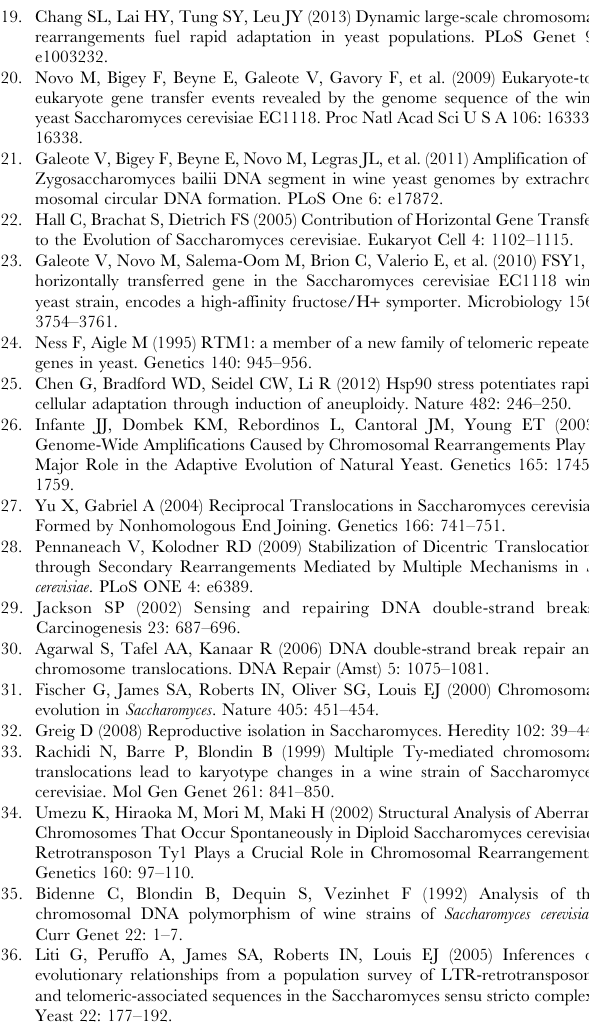
Table S4 Reads were done in pairs. See Materials and Methods for description of the assembly process. Coverage was